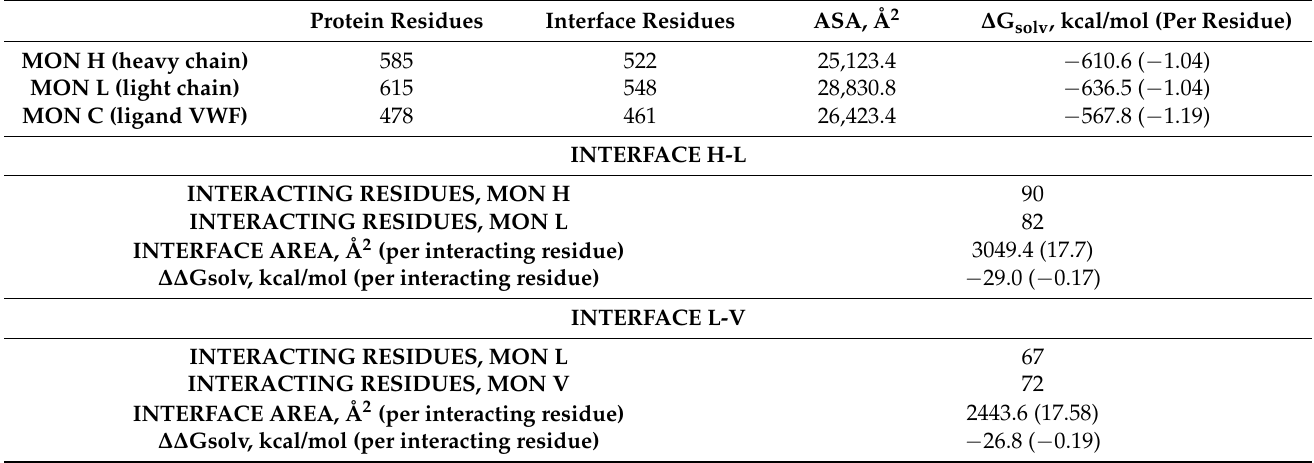
Table 5. PISA results for efanesoctocog alfa. Values within brackets refer to the value specific per residue. Accessible surface area (ASA) of interface (Å 2